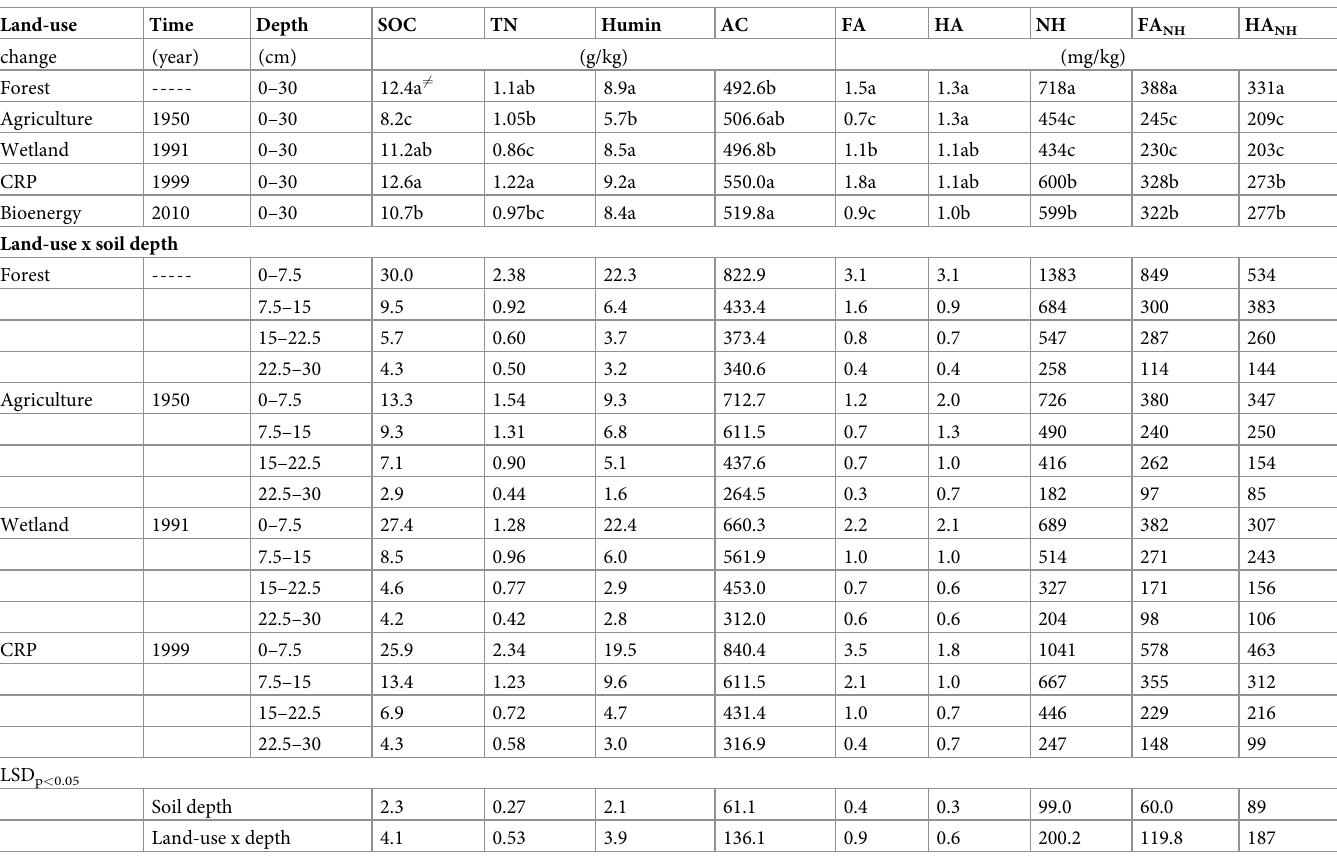
Table 2. Impact of deforestation and subsequent land-use diversity on total organic carbon (SOC), total nitrogen (TN), active carbon (AC), fulvic acid (FA), humic acid (HA), humin, and glucose equivalent total non-humic carbon (NH), fulvic acid associated glucose equivalent non-humic carbon (FA NH ), and humic acid associ- ated glucose equivalent non-humic carbon (HA NH ) contents at different soil